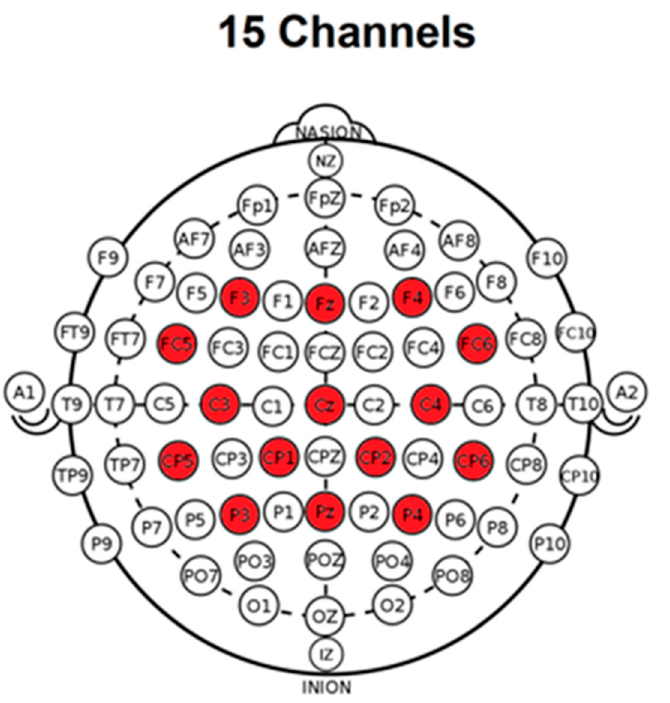
Figure 1. The spatial distribution of the electrodes. In red, the active electrodes.